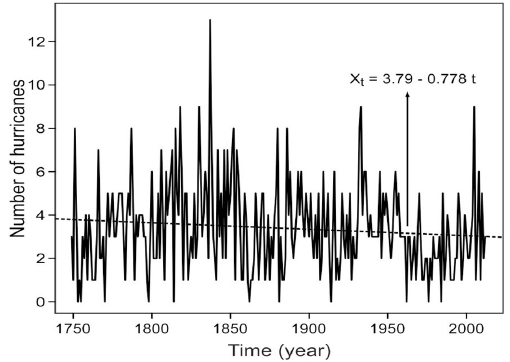
Figure 1. Hurricanes between 1749 and 2012. The dashed line shows the linear trend (after Rojo-Garibaldi et al.,